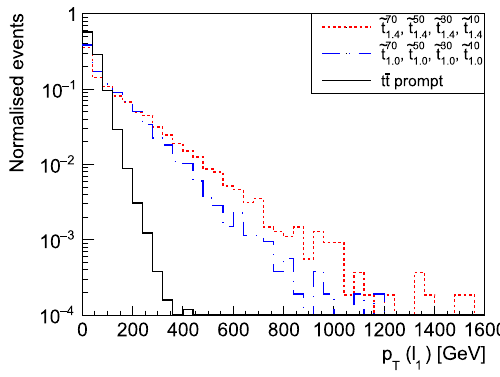
Fig. 57 Transverse momentum p T of the leading lepton in the stop squark ˜ t case